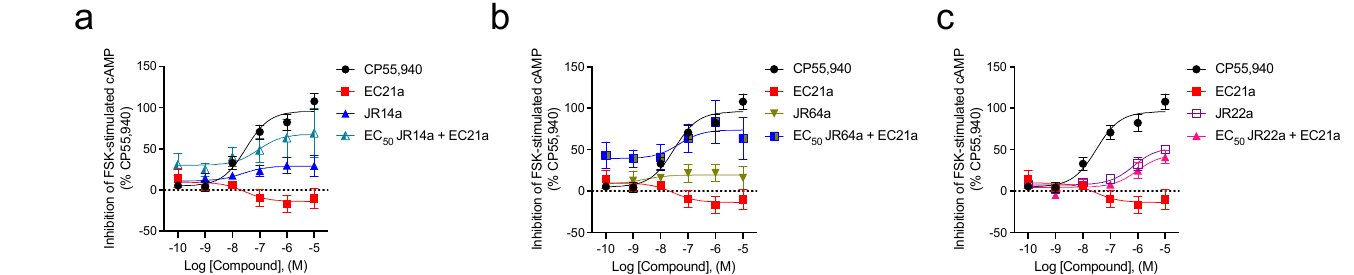
Figure 3. CB2R-dependent inhibition of FSK-stimulated cAMP in CHO cells stably expressing h CB2R. cAMP inhibition data are expressed as the %CP55,940 response. Cells were treated with ligands simultaneously, as indicated. 53 nM JR14a ( a ), 75 nM JR64a ( b ), and 100 nM JR22a ( c ) were chosen after the completion of preliminary experiments with compounds alone for ease of calculations to approximate the EC 50 for each compound alone. Data were fitted to a nonlinear regression (three ‐ parameter model, GraphPad v. 9.0). Data are mean ± S.E.M. 3 or more independent experiments performed in triplicate. Specific n values and data from these graphs are presented in Table 1.